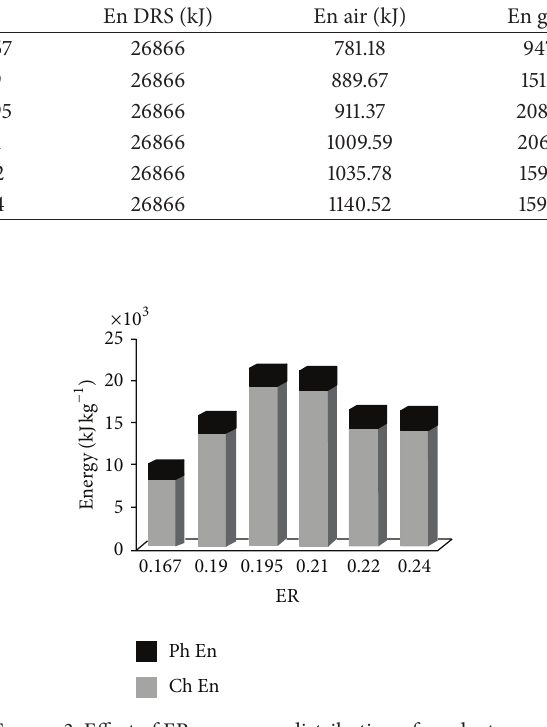
Figure 3: Effect of ER on energy distribution of product gas. Figure 4: Effect of ER on exergy distribution of product